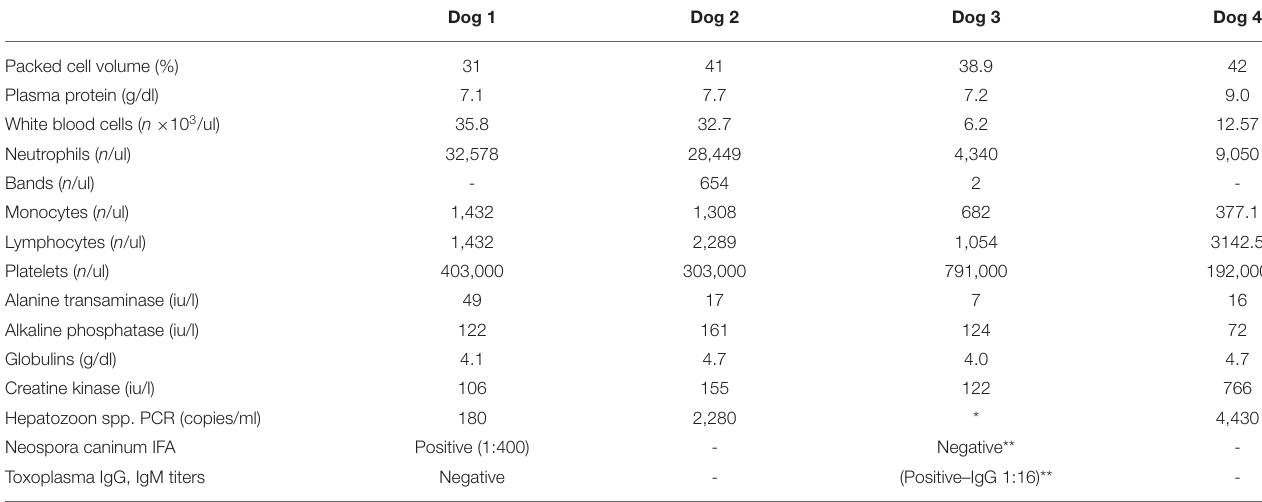
TABLE 1 | Comparison of pertinent laboratory